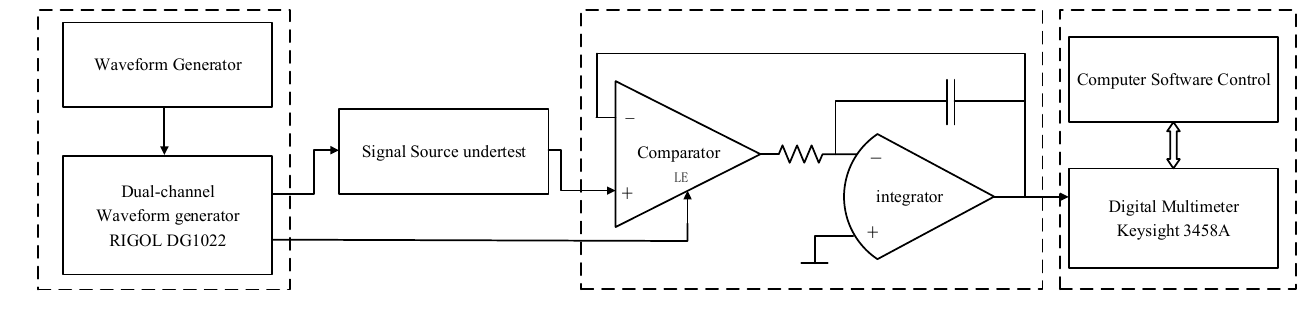
Figure 2. Structure of the system.